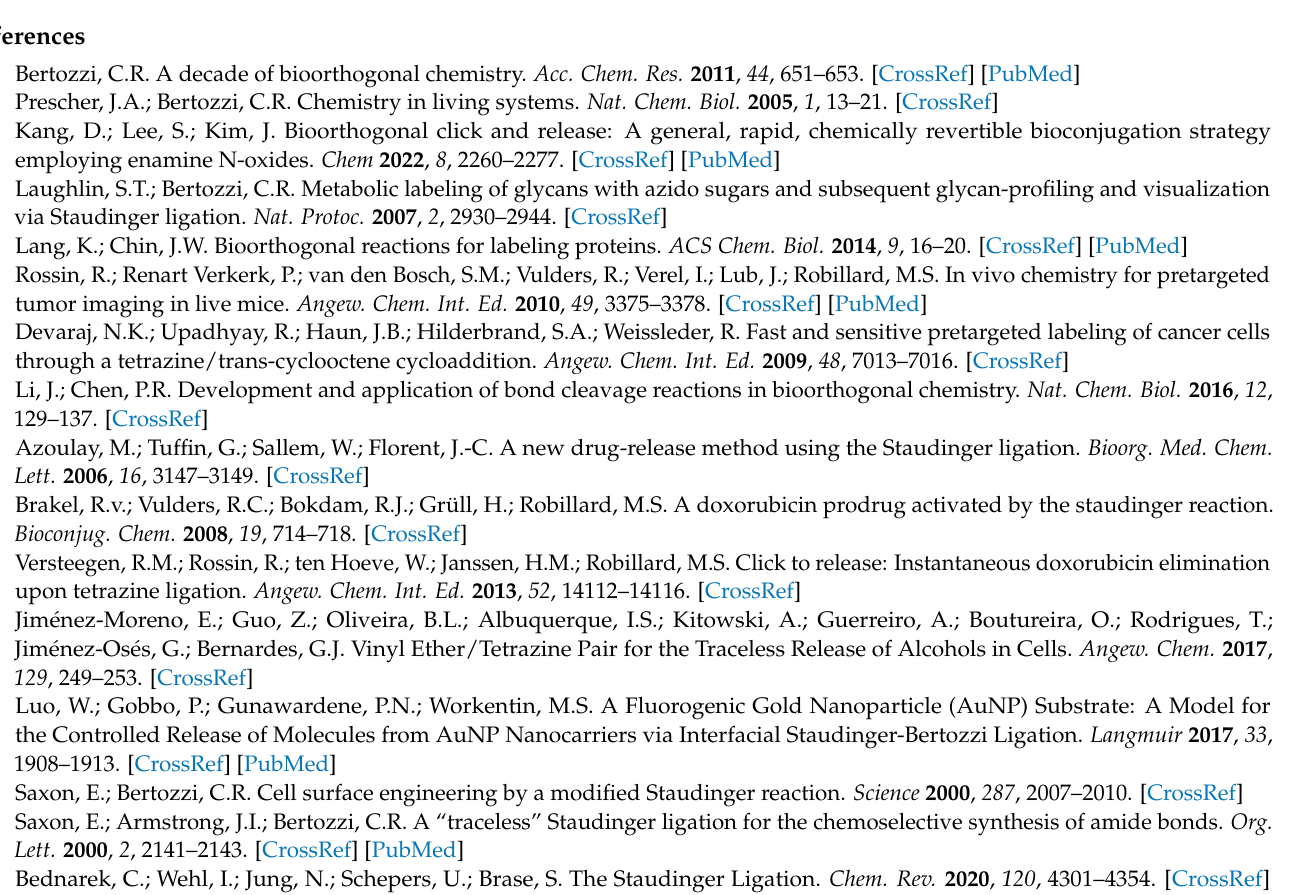
Figure S32: Radio-TLC analysis of in vivo Staudinger ligation in mice; Figure S33: Biodistribution